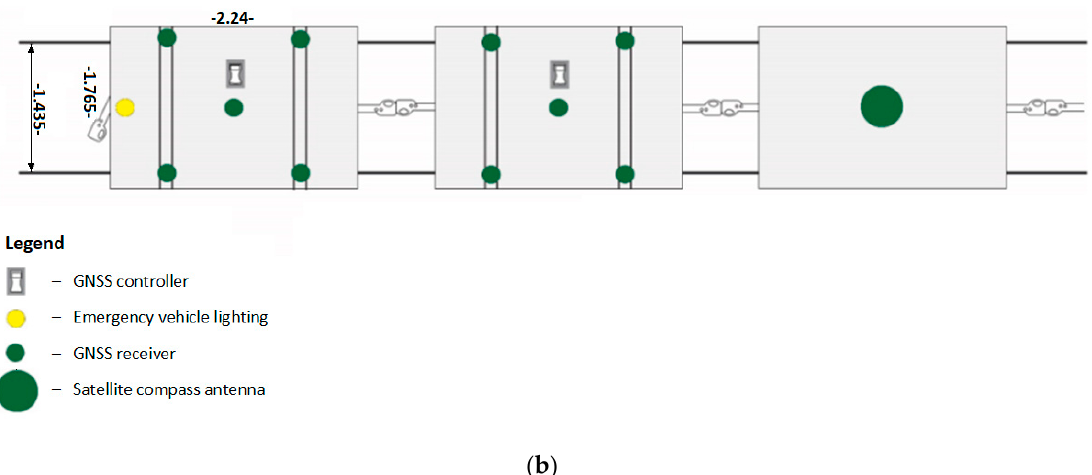
Figure 1. Mobile Measurement Platform (MMP) ( a ) with the layout of the measuring devices ( b ). Each platform had five receivers, deployed on a platform at the vertices and at the centre of a square. The diagram of the MMP is shown in Figure 2.